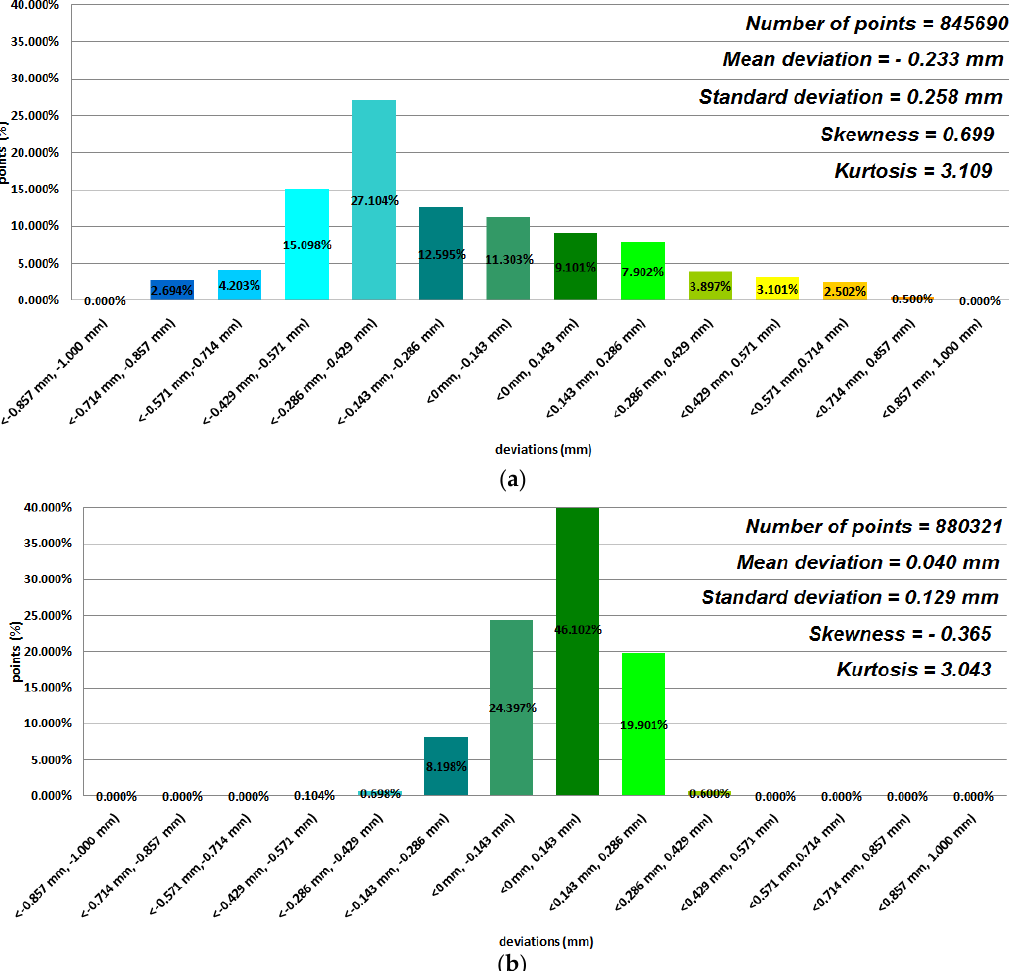
( c ) Figure 5. Histograms representing average results of the 12 mandible structures: ( a ) Polyethylene terephthalate ( PET) material; ( b ) E-Partial material; ( c ) E-Denstone material.